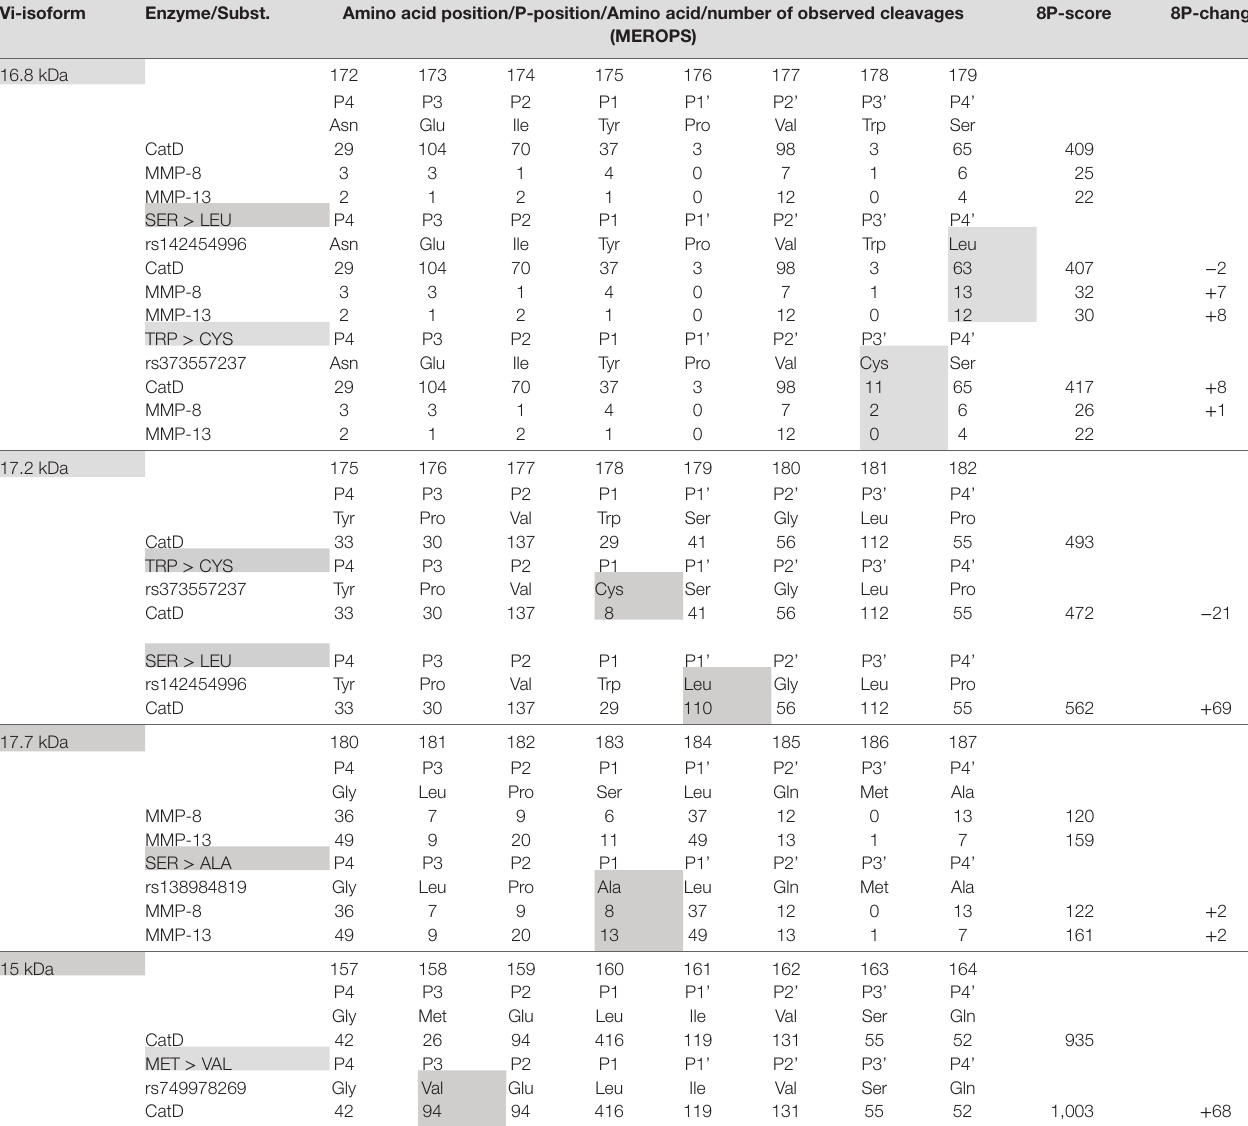
TaBle 1 | Effect of single amino acid substitutions on vasoinhibin isoforms generation. Vi-isoform